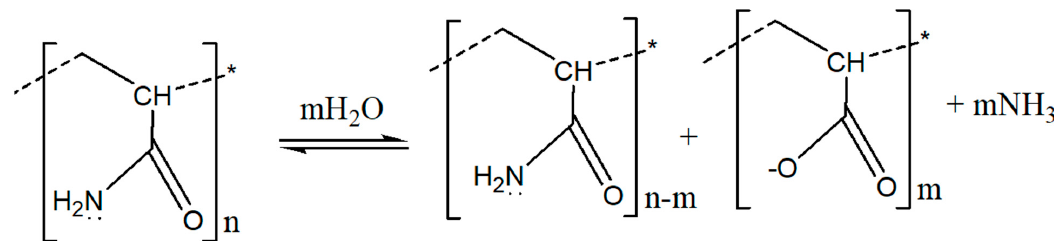
Figure 1. Polyacrylamide (PAM) hydrolysis in water to form hydrolyzed HPAM and ammonia.